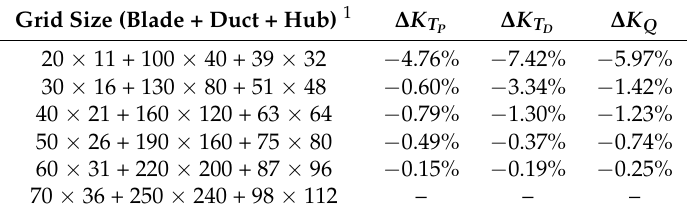
Table 1. Variation of open-water characteristics with different grid sizes compared to the finest grid. Panel method computations at J =